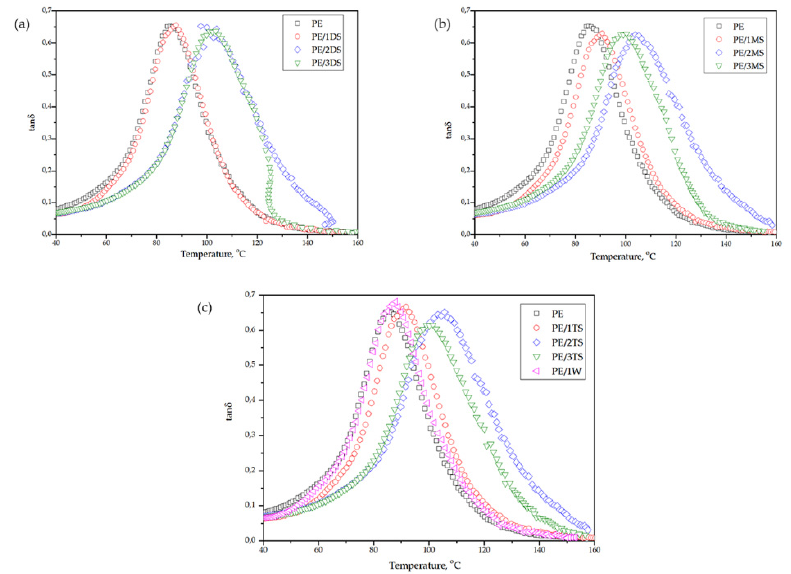
Figure 15. Temperature dependence of tan δ of plane epoxy and corresponding composites for ( a ) PE, PE/1DS, PE/2DS, and PE/3DS ( b ) PE, PE/1MS, PE/2MS, PE/3MS ( c ) PE, PE/1TS, PE/2TS, PE/3TS, and PE/1W.